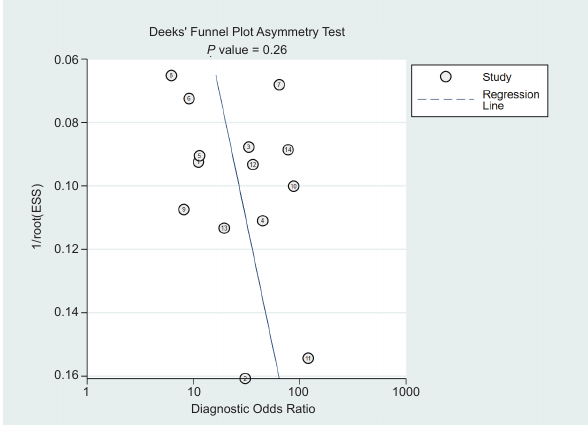
Figure 6 The Deek's funnel plot of SMI to distinguish breast masses.